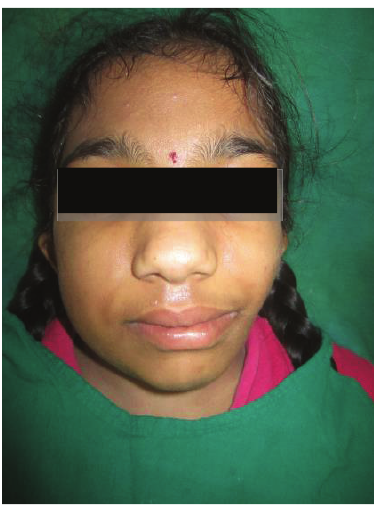
Figure 3: Deviation of the jaw to the left